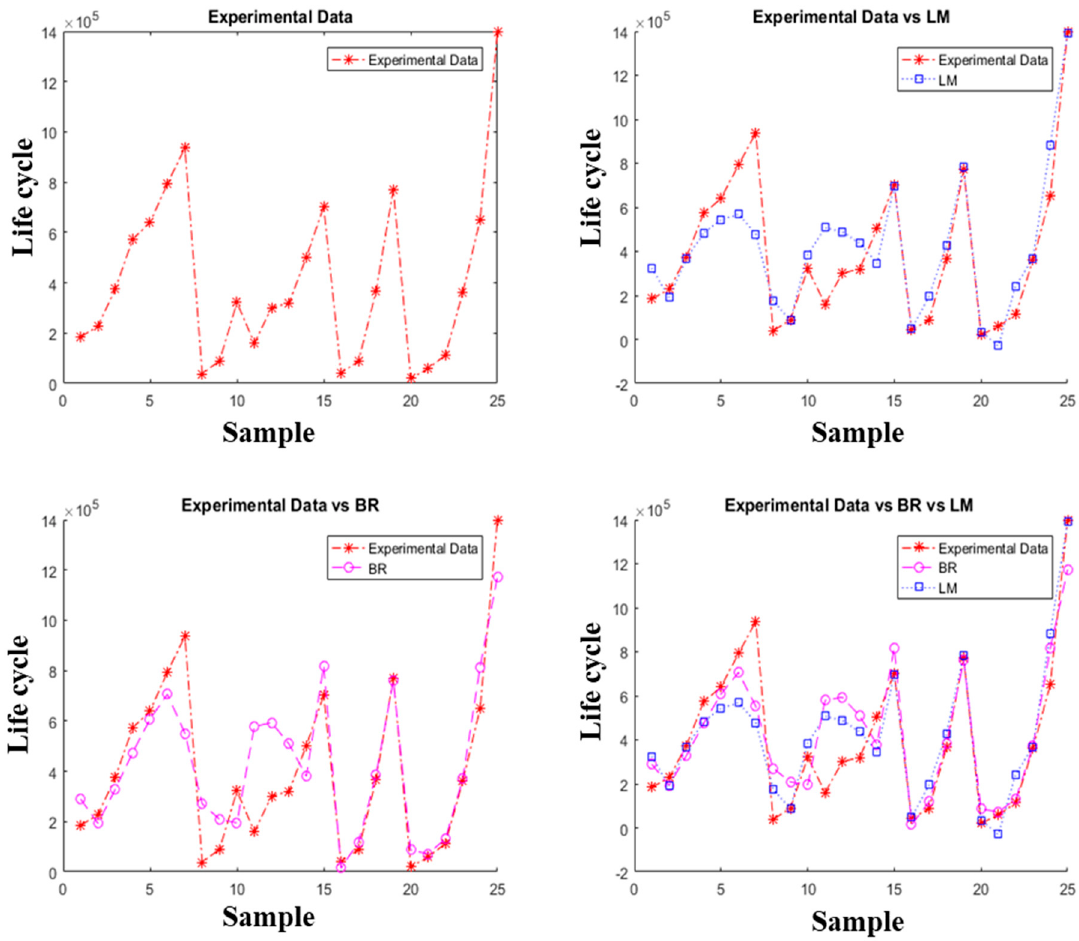
Figure 9. Corrosion fatigue life prediction.